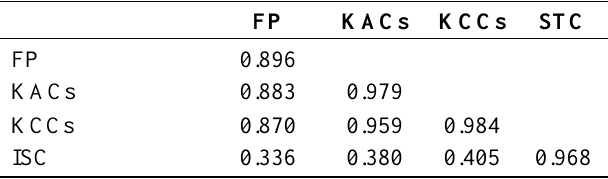
Table 6: Discriminant Validity of Third-Order